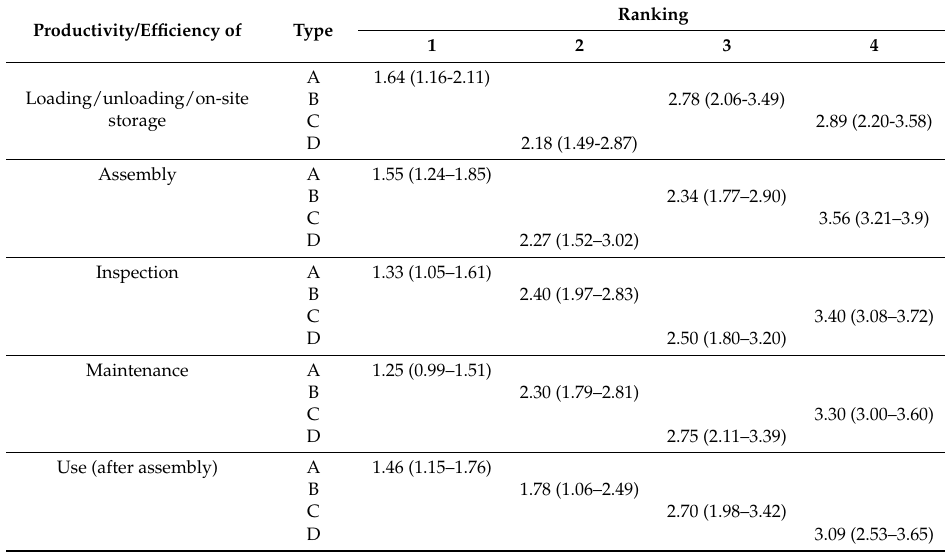
Table 5. Evaluation ranking of safety levels of different types of